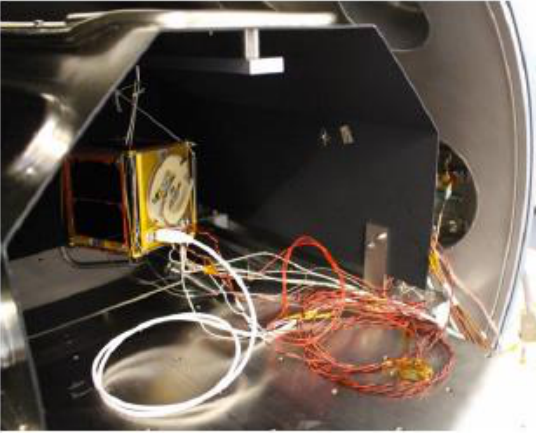
Figure 13. E-st@r-II installed in MARSIM.